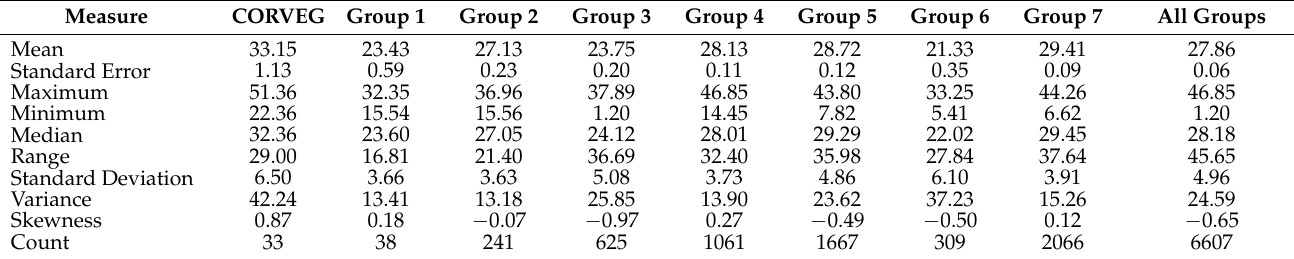
Table 9. Differences in the maximum heights between the CORVEG and Koala Coast intra-subregional virtual plots; significant p -values (ANOVA with post hoc tests, df 1 = 7, df2 = 6032, F = 231.483) are shown in bold. We also compared the CORVEG plots to the pooled group plots (Welch’s t -test, df = 6038, F = 4.434). Except for Group 7, all the groups were significantly different to CORVEG, and Group 1 was not significantly different to Groups 3 and 6. n.a. = not applicable.